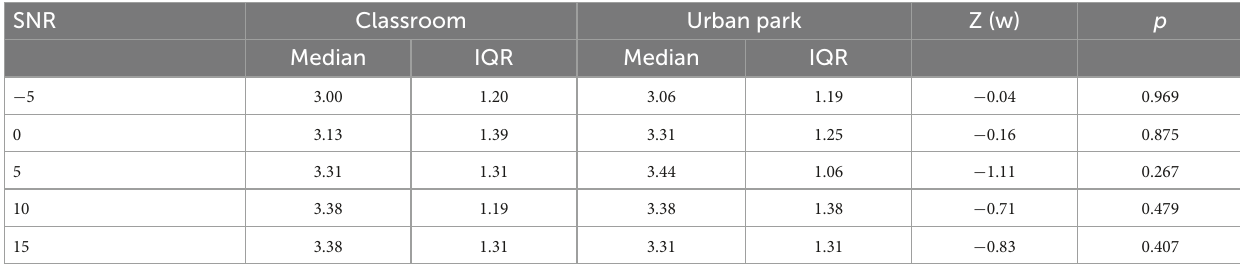
TABLE 4 Comparison of perceived restorativeness of each SNR between a classroom and urban